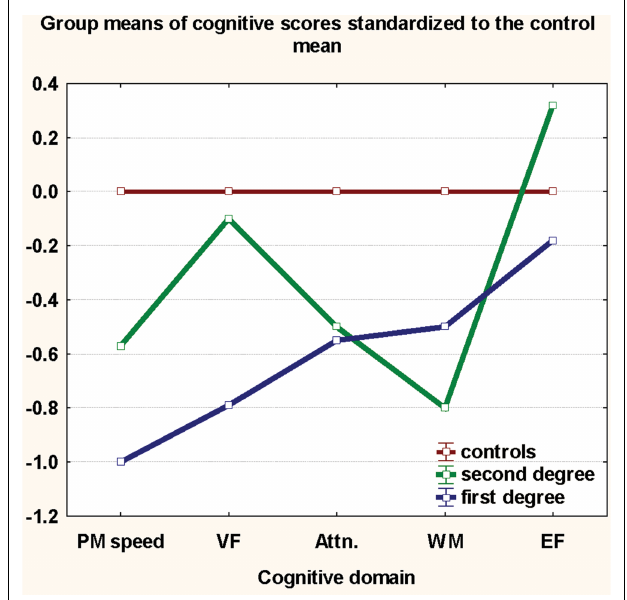
Table 2 denotes defi cits seen in fi rst- and second-degree